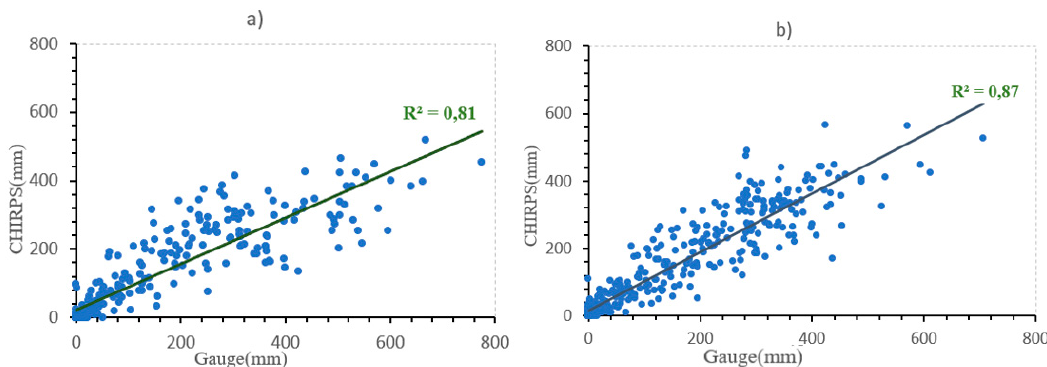
Figure 4. Scatter plot comparison of monthly rainfall, between rain gauge and CHIRPS satellite rainfall estimates for 2005–2015: ( a ) Lowland regions; ( b ) Highland regions.